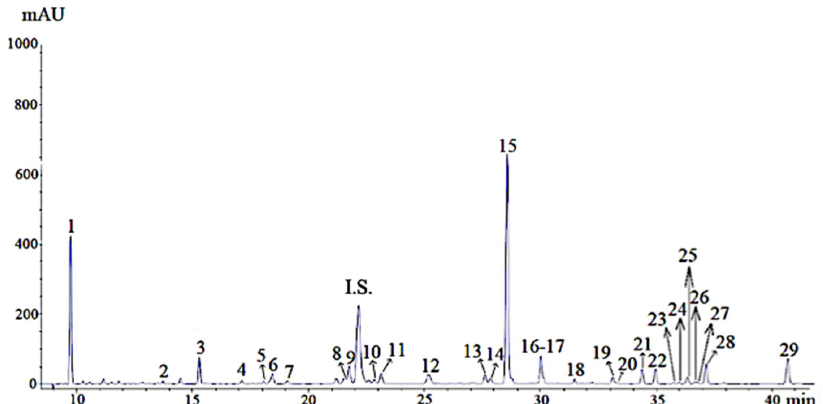
Figure 1. Chromatogram of phenolic compounds of UAE marjoram extract. Note: The numbers of the peaks correspond to the compounds listed in Table 1. I.S.: internal standard (Ethyl gallate). Table 1. Phenolic composition of UAE marjoram extract.